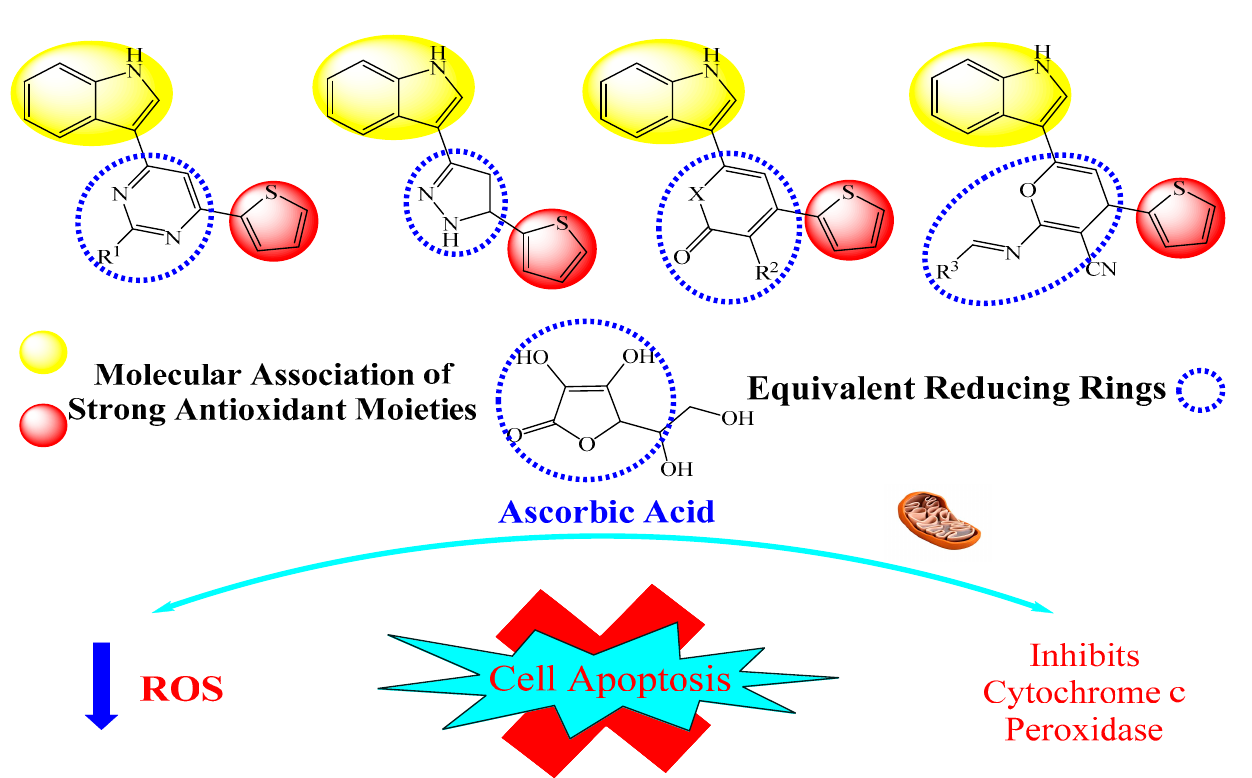
Figure 1. Rationale of the newly synthesized 1 H -3-indolyl derivatives using molecular association.